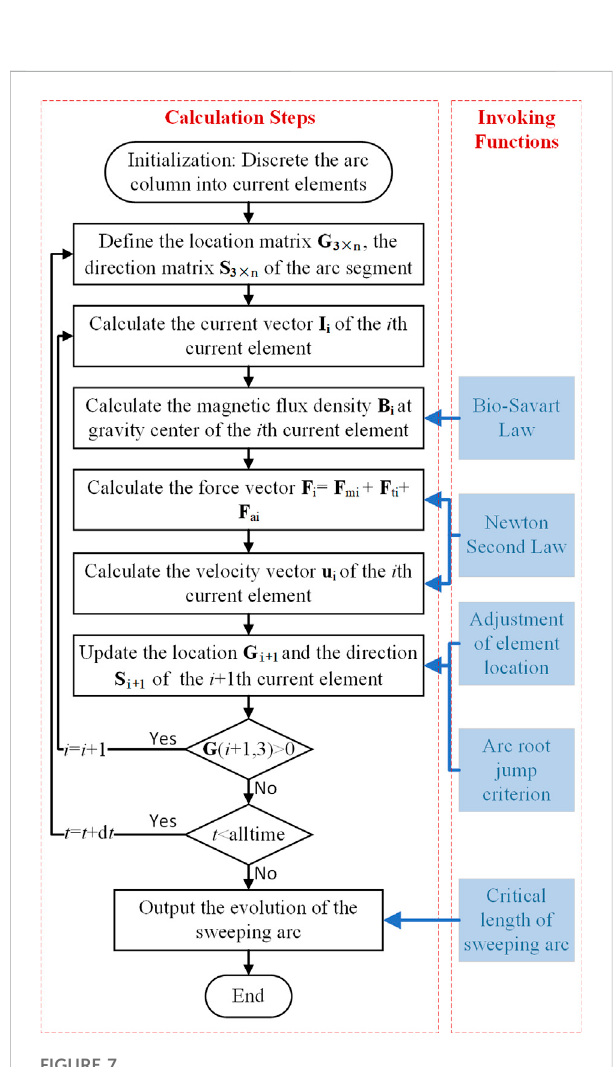
FIGURE 7 Flow chart of the sweeping arc